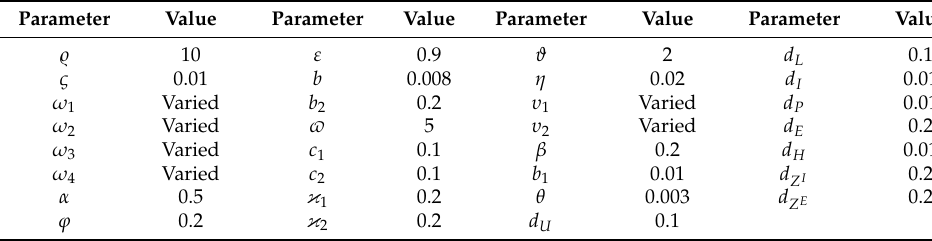
Table 2. List of parameters of Model